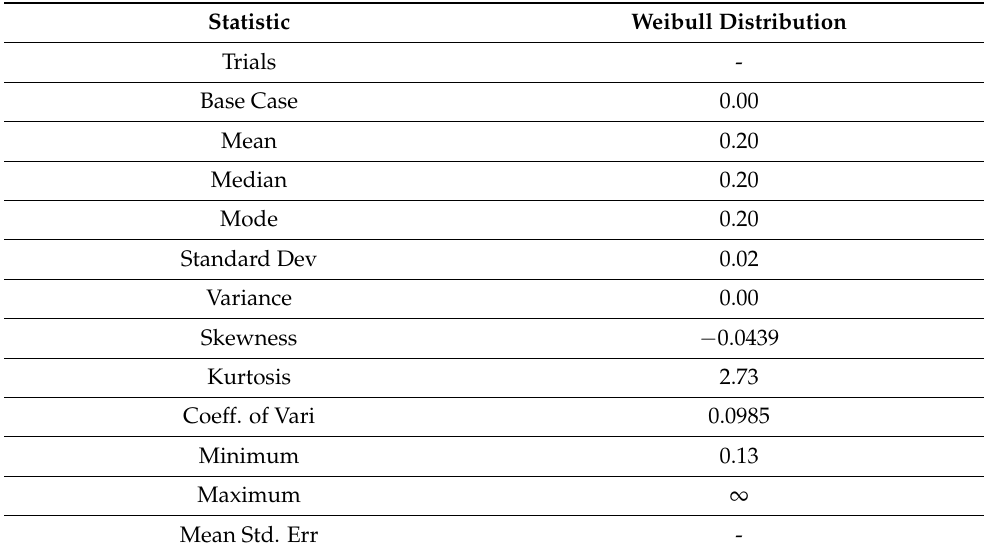
Table 3. Descriptive statistics of the probability distribution of accommodation facility occupancy in Liptov.